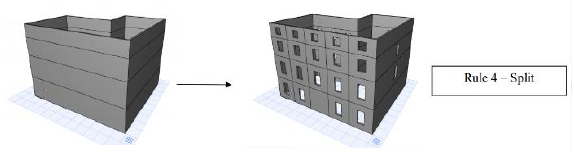
Figure 12. The fourth procedural rule is a split rule which is used to subdivide a façade or floor.